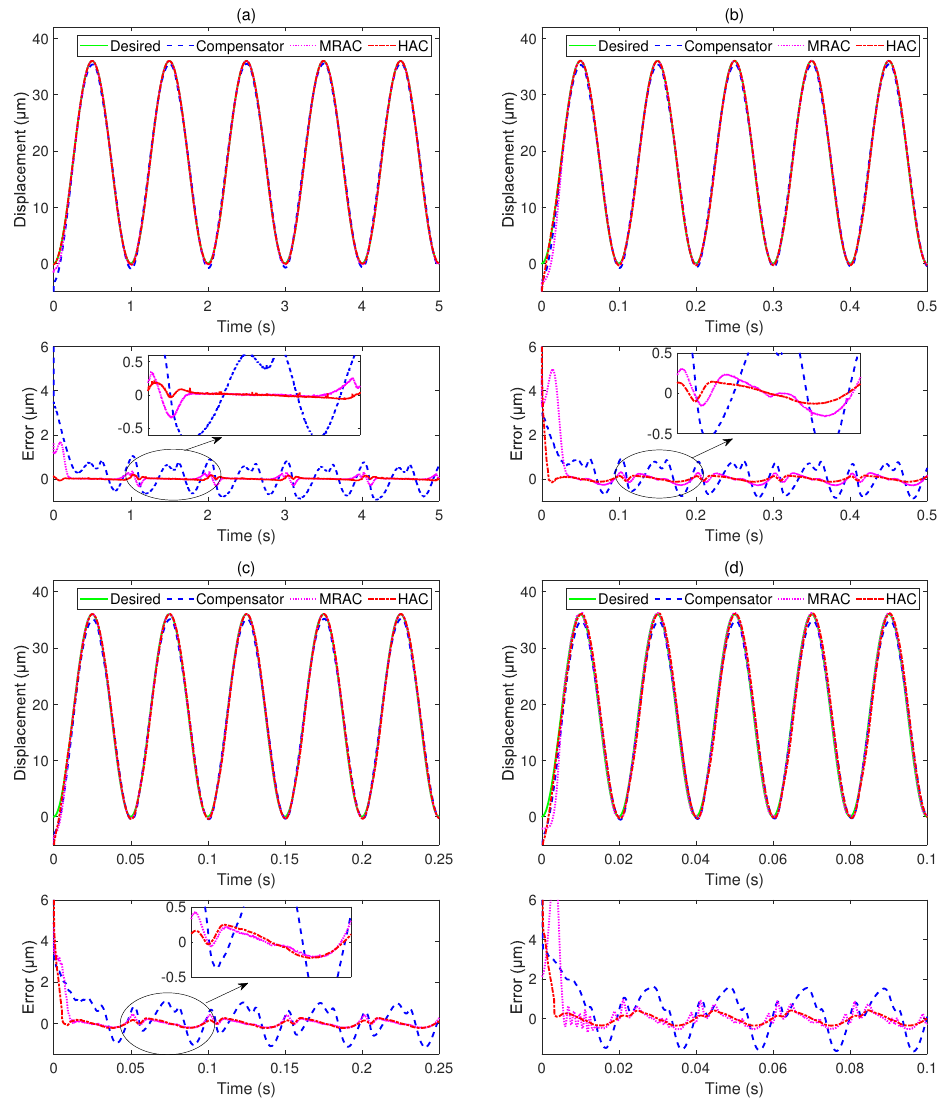
Figure 6. Tracking performance of the HAC method in comparison with the compensator and MRAC under sinusoidal reference trajectories of different frequencies: ( a ) tracking result at frequency of 1 Hz; ( b ) tracking result at frequency of 10 Hz; ( c ) tracking result at frequency of 20 Hz; ( d ) tracking result at frequency of 50